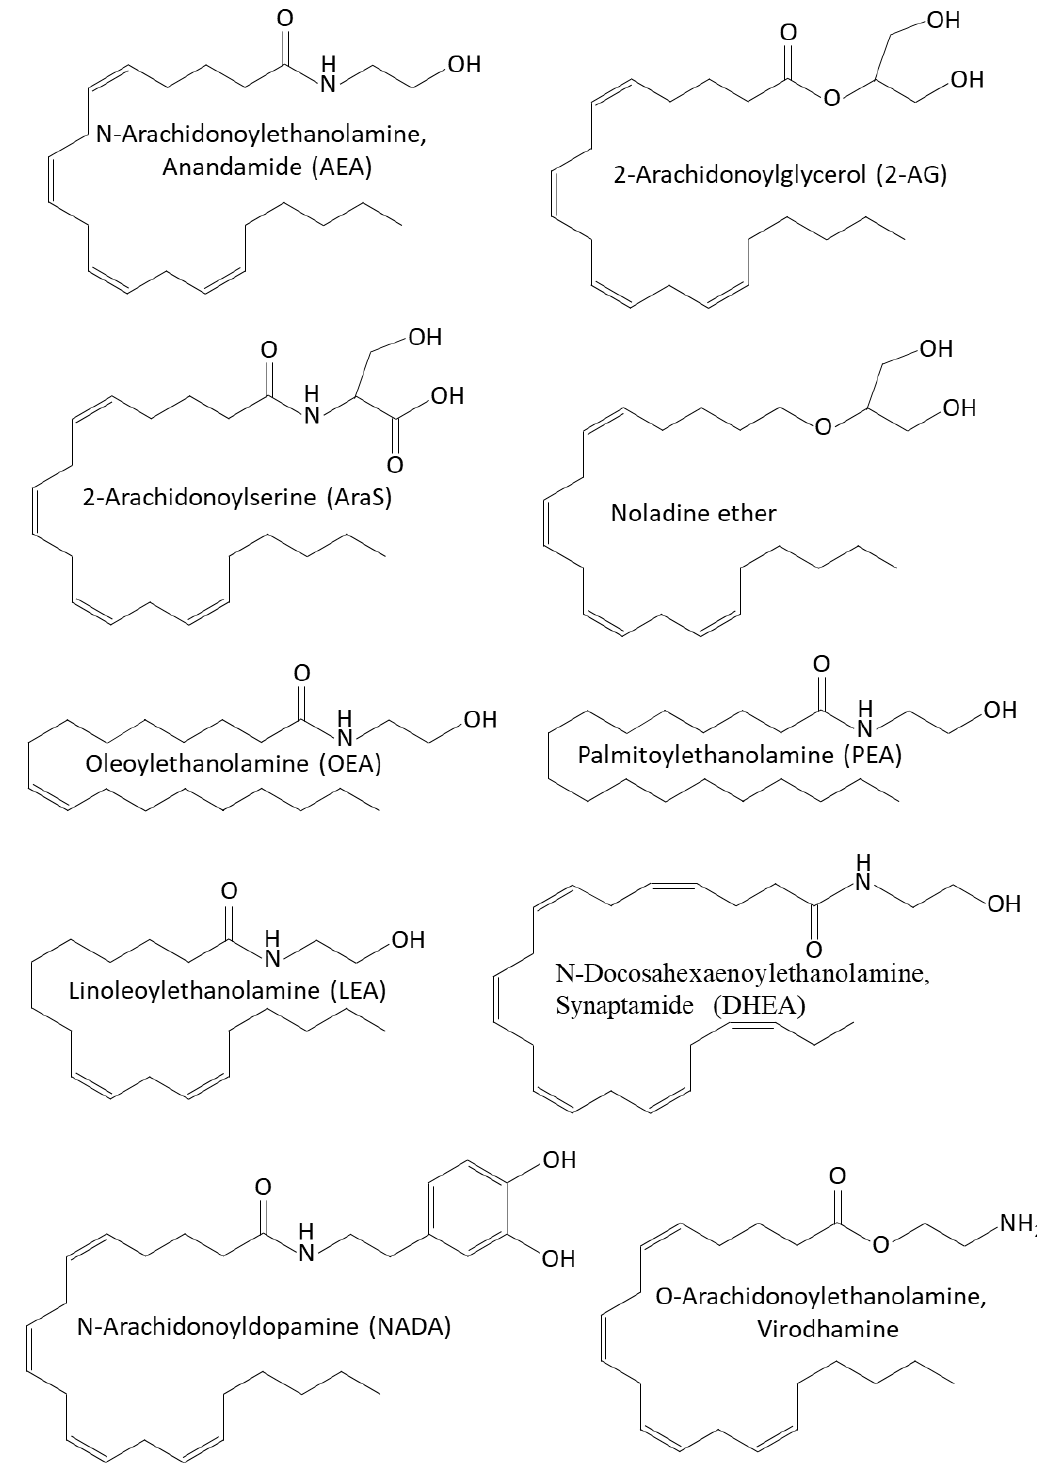
Figure 3. The chemical structures of some endocannabinoids. Another communication system that exists between neurons is the release of lipid- based transport systems such as exosomes from neurons following a synaptic response, that are taken up by neighboring cells [350,351]. Gabrielli et al. [352] observed that endo- cannabinoids are secreted on extracellular membrane vesicles. In this study, extracellular vesicles secreted by microglial cells were found to carry AEA on their surface that